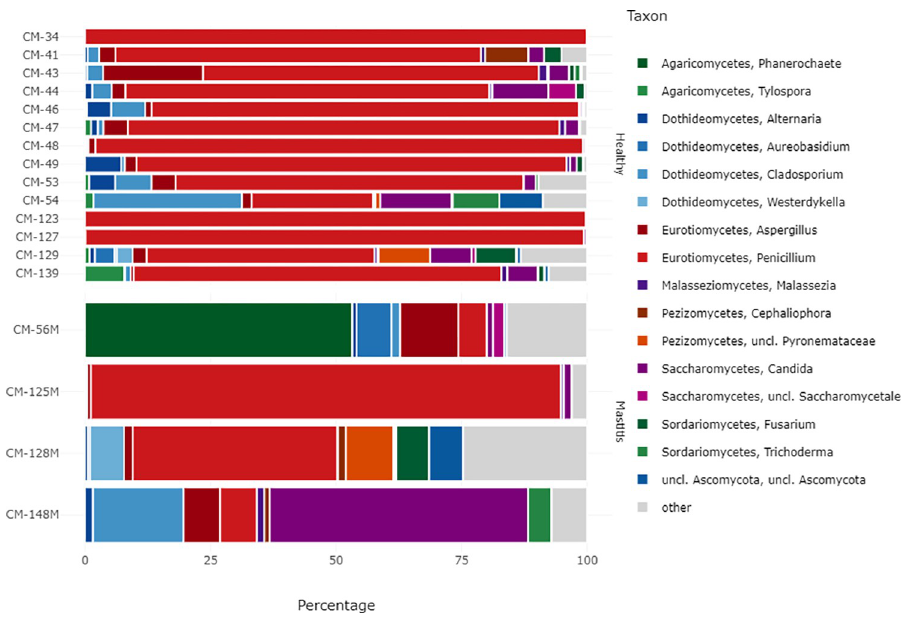
Fig 6. Taxon frequencies (percentage of total sample counts) of the most dominant bacterial population in healthy and mastitis camel milk summarized at the genus level for the ITS. Rare taxa with a mean abundance of < 1% across all samples are summarized as “Others”. M corresponds to the mastitis samples.